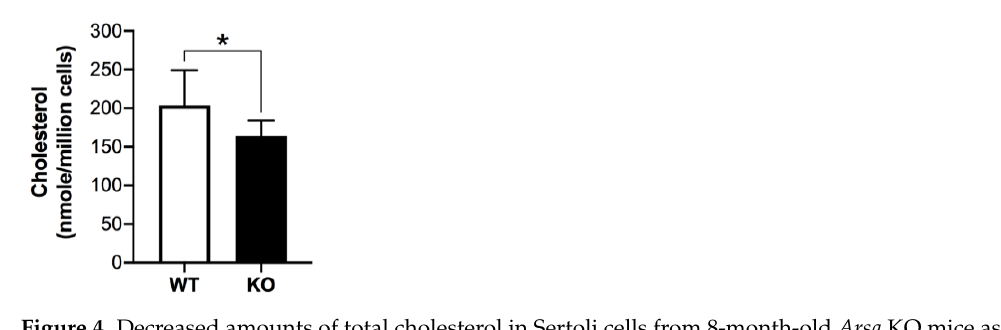
H 2 O 2 in Sertoli cells from both 5-month-old and 8-month-old Arsa −/− mice were significantly higher than those in Sertoli cells from age-matched WT animals.